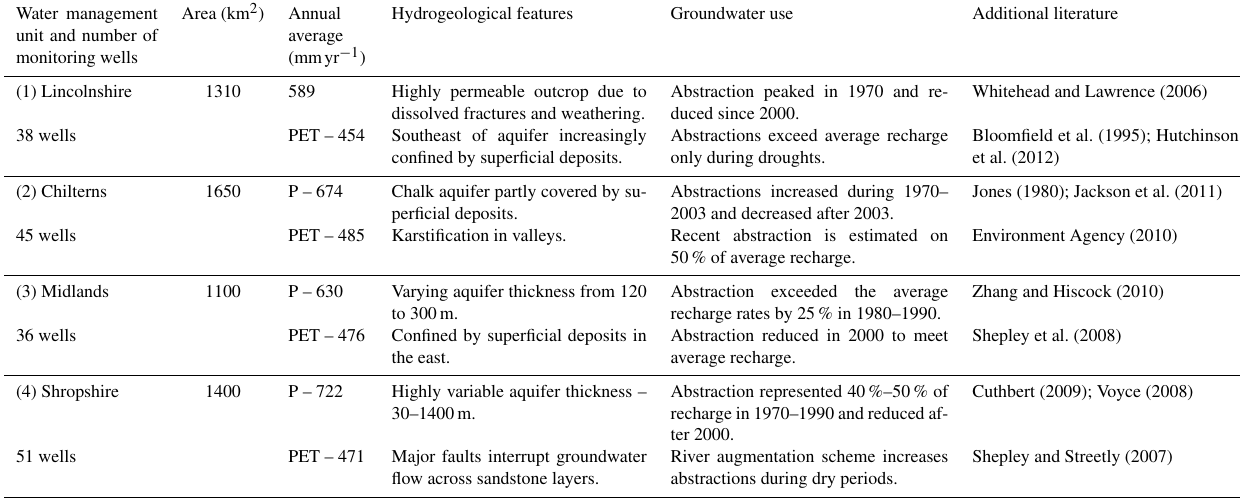
Table 1. Regional features of the four water management units summarising the area size, long-term precipitation ( P ), and potential evapo- transpiration (PET), as calculated by Mansour and Hughes (2018) based on daily data from 1962 to 2016, hydrogeological features, and main groundwater use changes in time. The location of the water management units is shown in Fig. 1. In Fig. S1, the purpose and locations of recent abstraction licenses are shown. Hydrogeological information and groundwater use is based on Allen et al. (1997) and complemented with additional references (see last